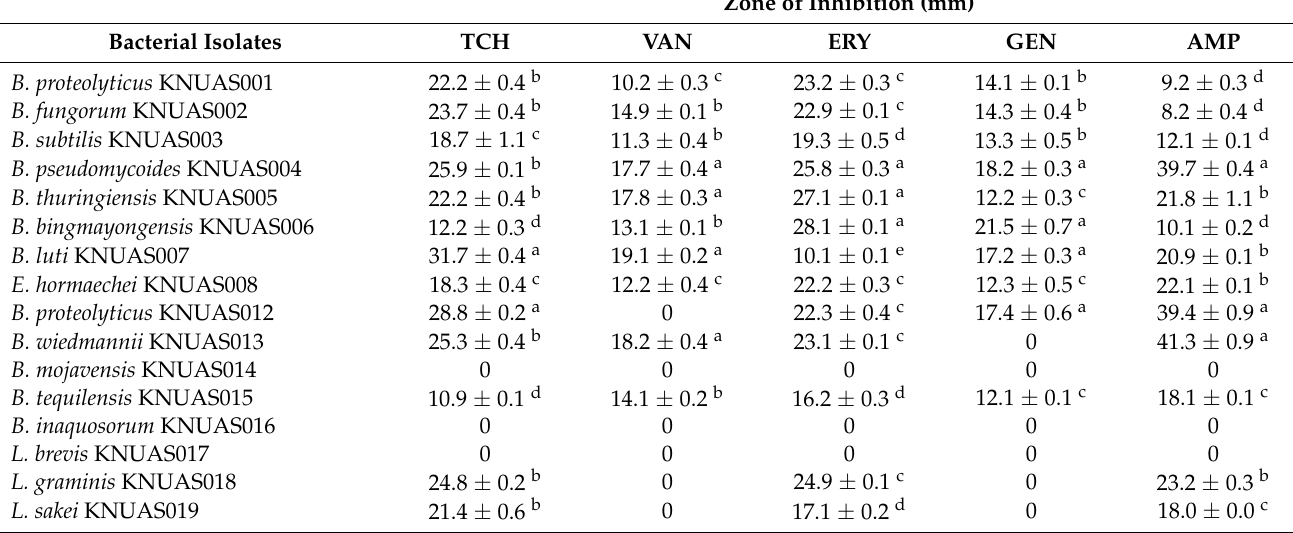
Figure 2. Hemolytic properties of isolated bacterial strains. α -hemolysis, green color in the medium; β -hemolysis, blood lysis, clear zone and γ -hemolysis, no changes in the medium, non-hemolytic. Table 4. Antibiotic susceptibility of isolated bacterial strains. Tetracycline hydrochloride (TCH, 30 µ g); vancomycin hydrochloride (VAN, 30 µ g); erythromycin (ERY, 15 µ g); gentamicin sulfate (GEN, 10 µ g); ampicillin sodium salt (AMP, 10 µ g). ≤ 15 mm, resistance; 15–21 mm, intermediate; and ≥ 21 mm, susceptible. The different superscript letters follow values indicating the significance among the samples ( p < 0.05). Zone of Inhibition